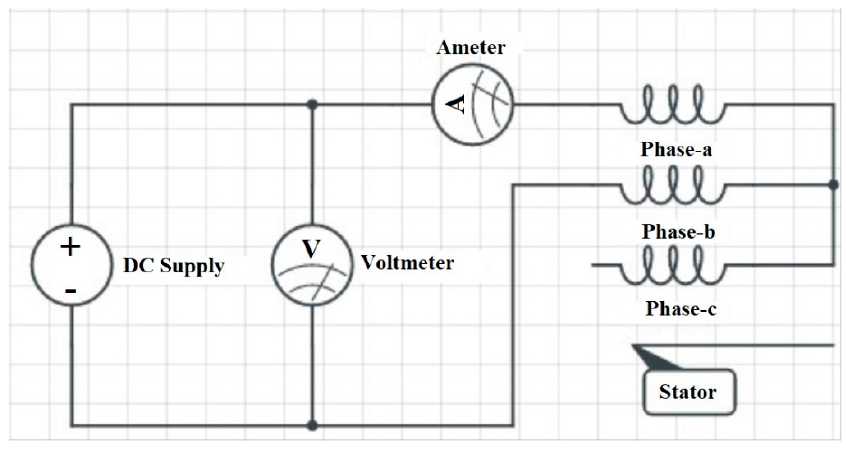
Figure 3. DC test circuit diagram.